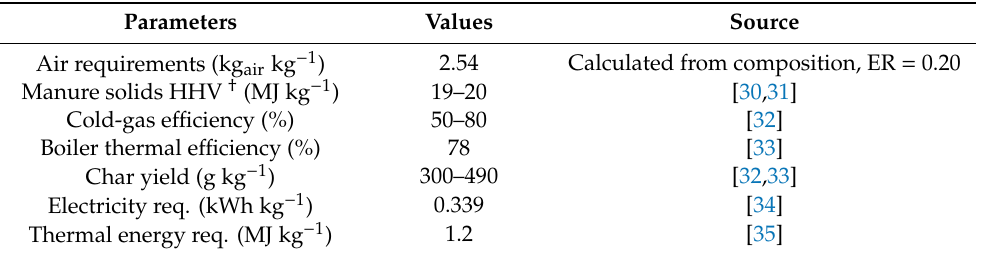
Table 3. A gasification process model for 1 kg of dry (15% moisture) swine manure solids.